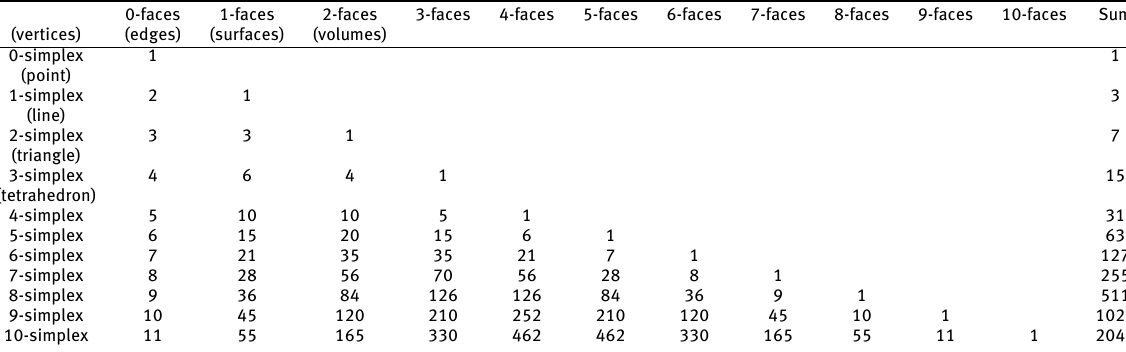
Table 1: m -faces of a k -simplex for 0 ≤ k ≤ 10 and 0 ≤ m ≤ 10 : in the ( k + 1) th row, the sum of the elements is equal to 2 k +1 − 1 .